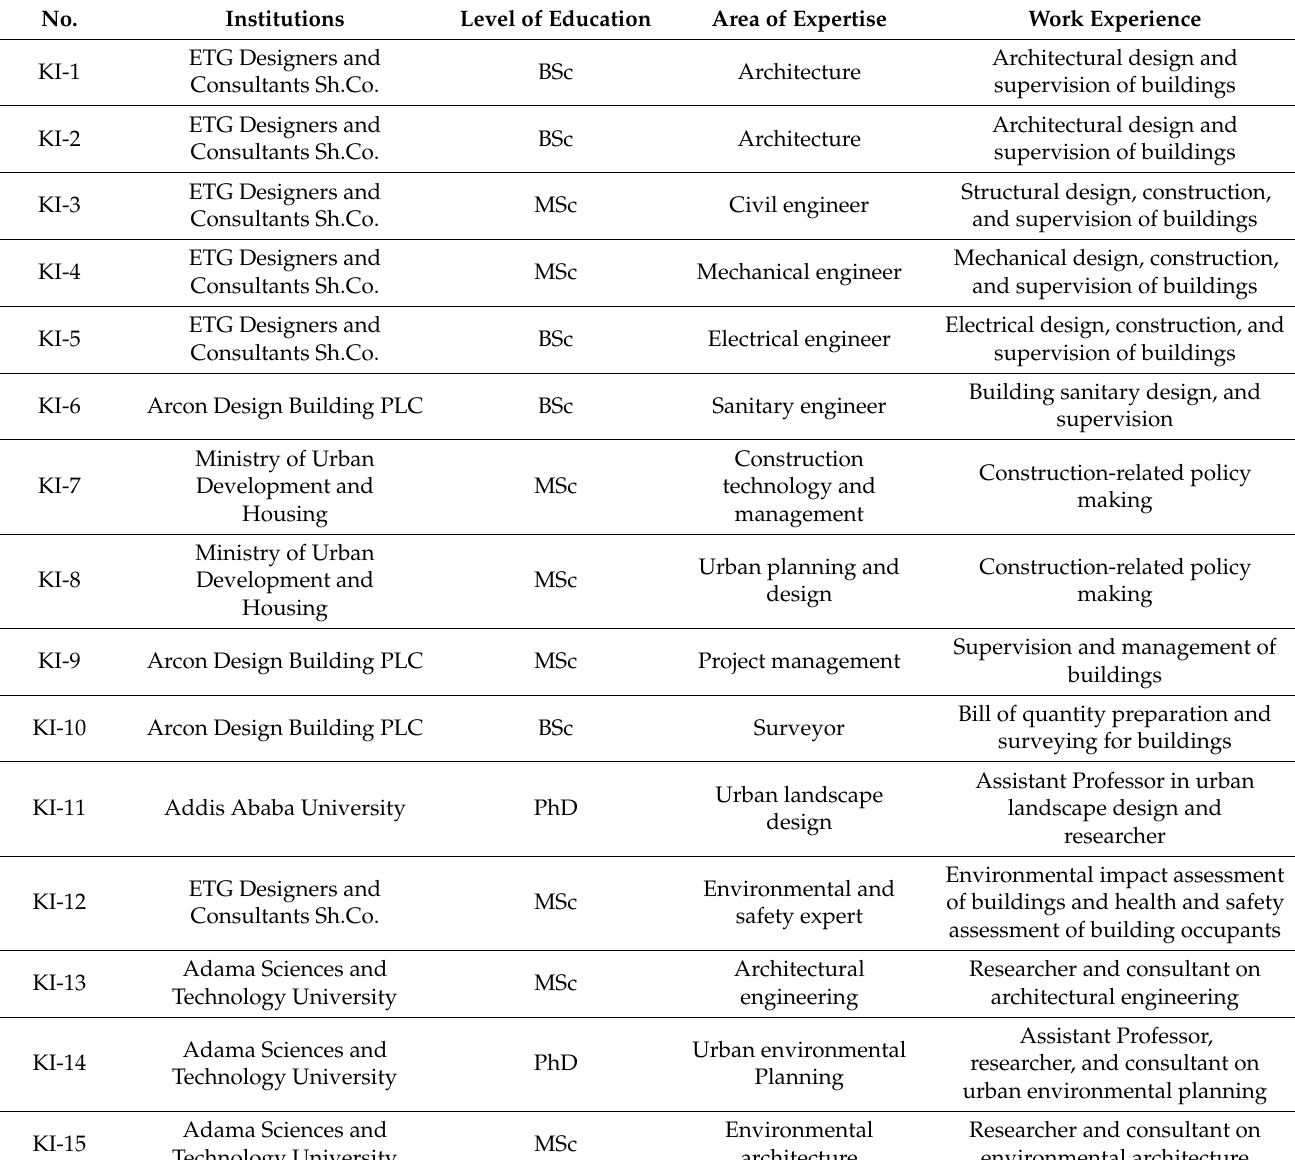
Table 1. Level of education, area of expertise, institutions, and work experience of interviewed key